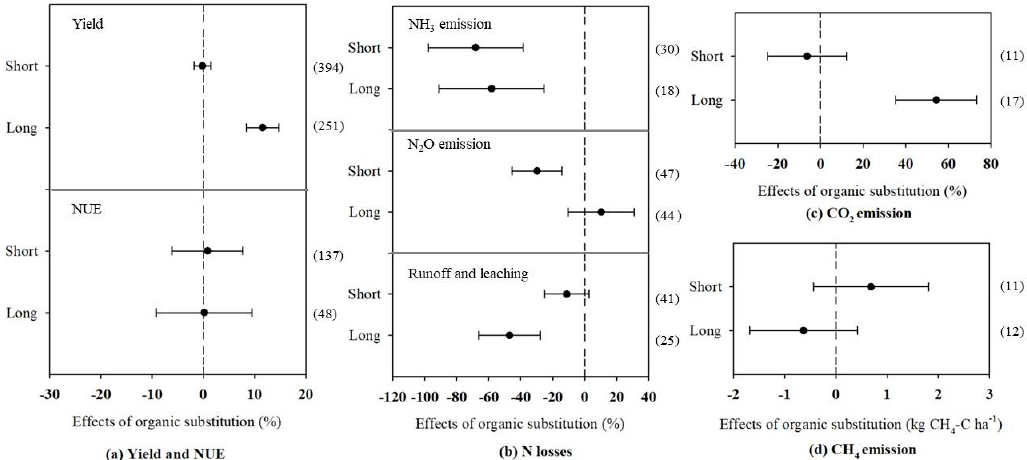
Figure 8. Effects of organic fertilizer substitution on maize yield and nitrogen use efficiency (NUE) ( a ), nitrogen (N) losses ( b ), CO 2 emissions ( c ), and CH 4 emissions ( d ) under two treatment durations (short: < 3 years, long: ≥ 3 years). N losses include NH 3 emissions, N 2 O emissions, and runoff and leaching. Error bars represent 95% confidence intervals. Numbers in parentheses indicate the numbers of observations.